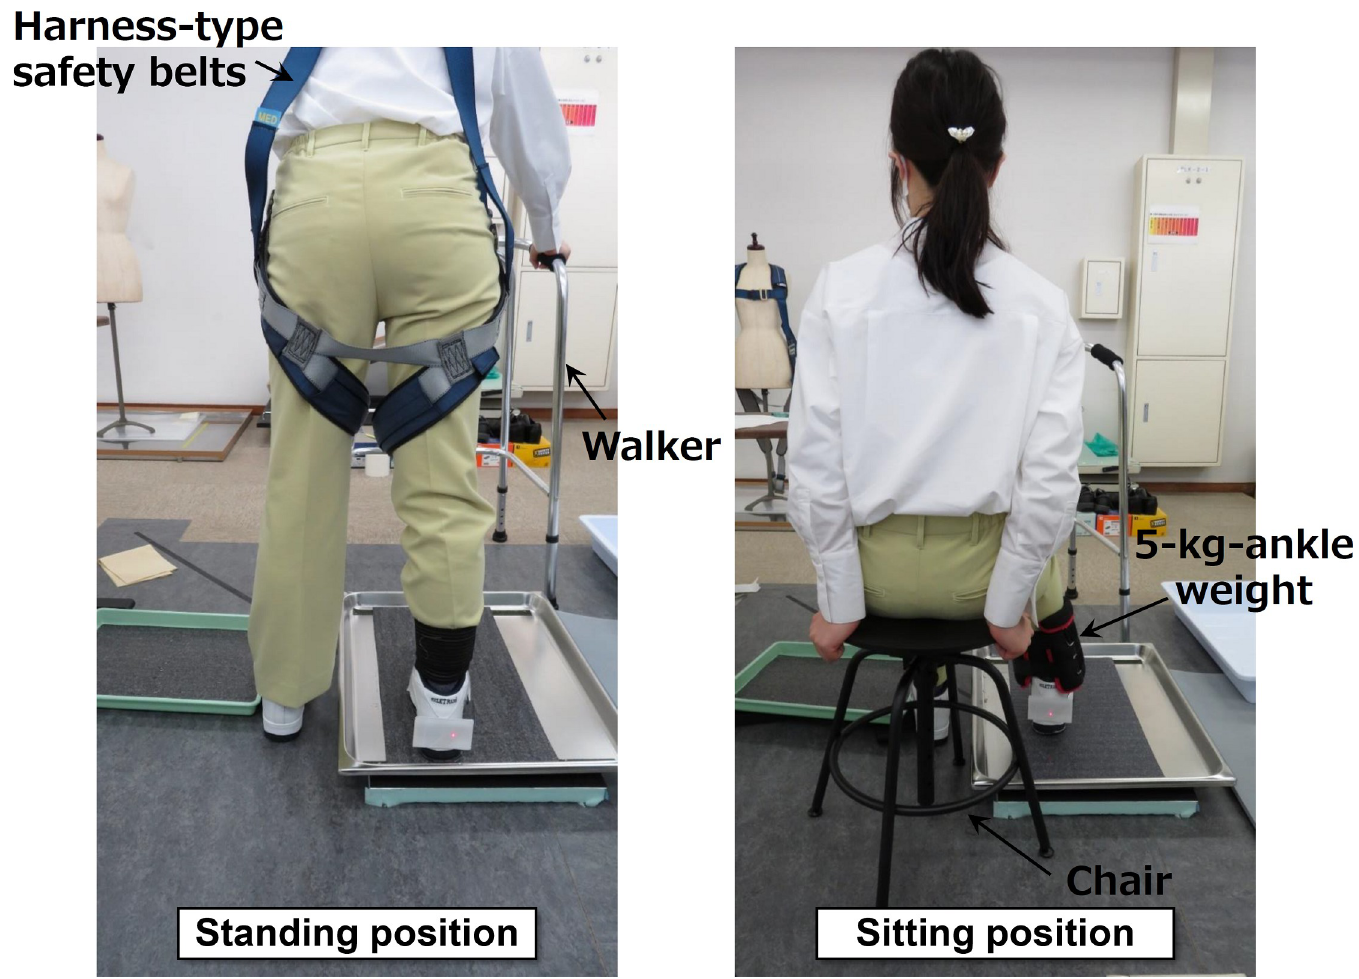
Fig 4. Photos of participants in standing and sitting